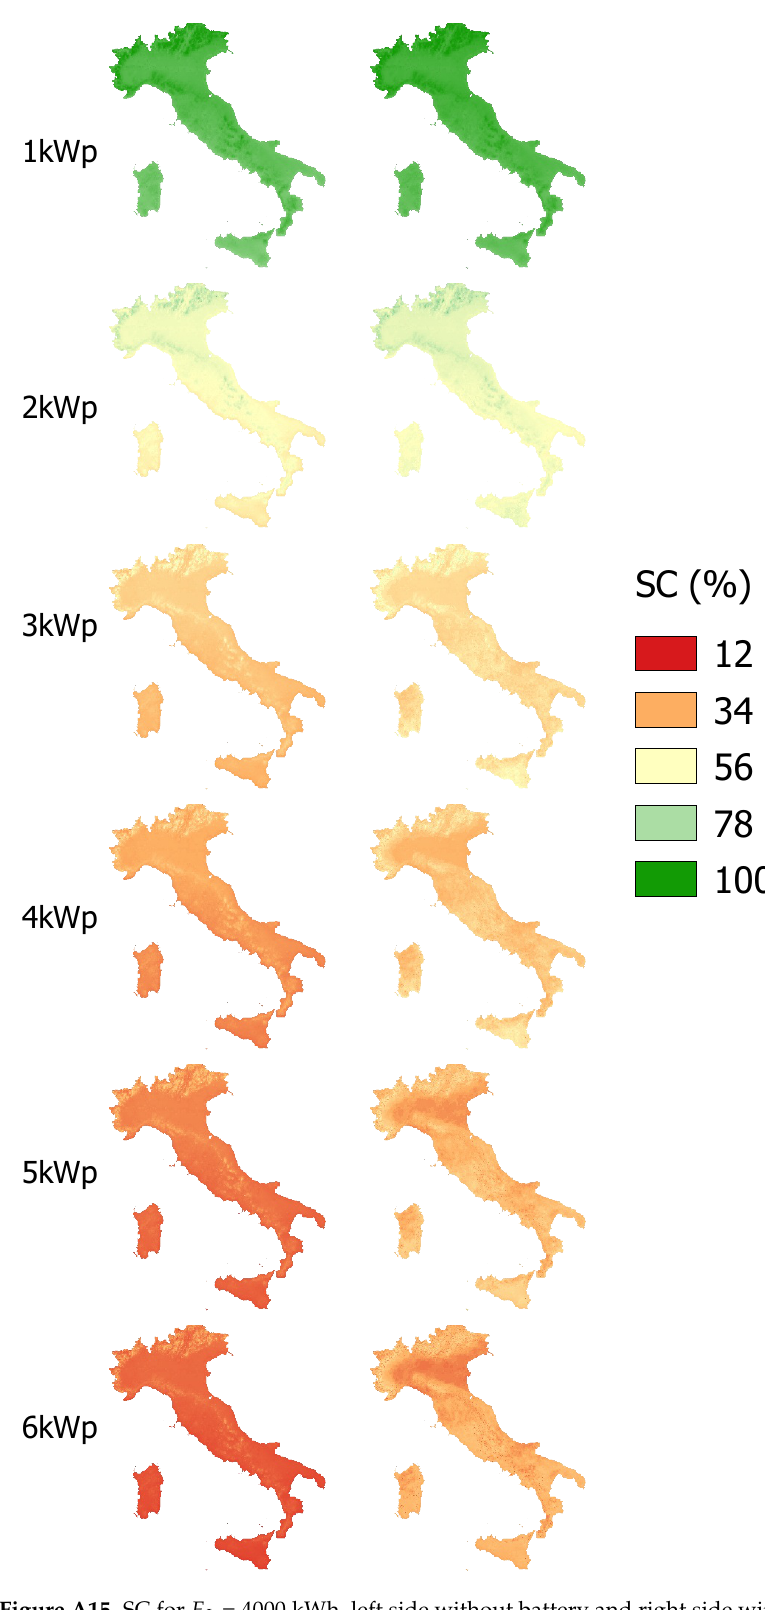
Figure A15. SC for E L = 4000 kWh, left side without battery and right side with